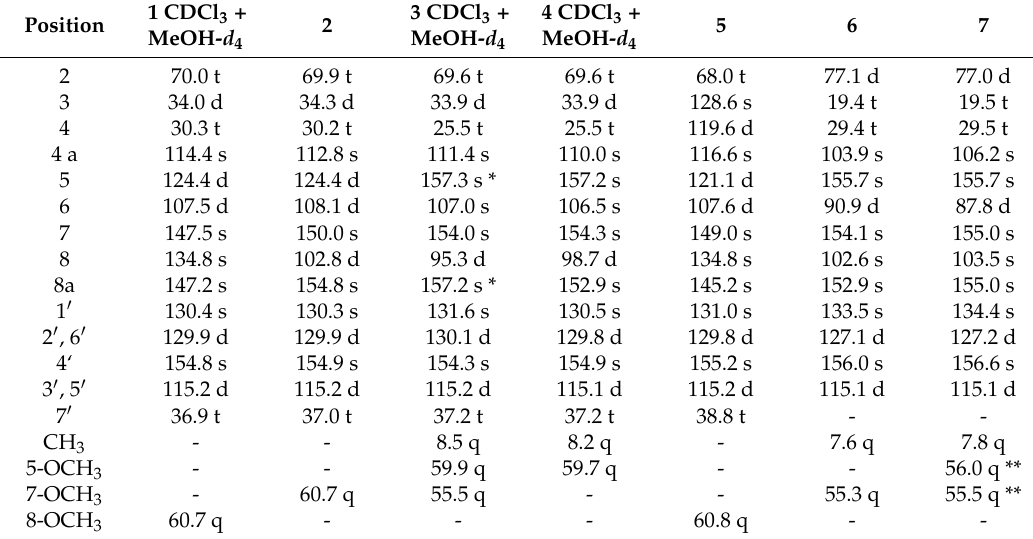
Table 2. 13 C-NMR Spectral Data of Compounds 1 – 7 (100 MHz, CDCl 3 or CDCl 3 + MeOH- d 4 , δ -values in